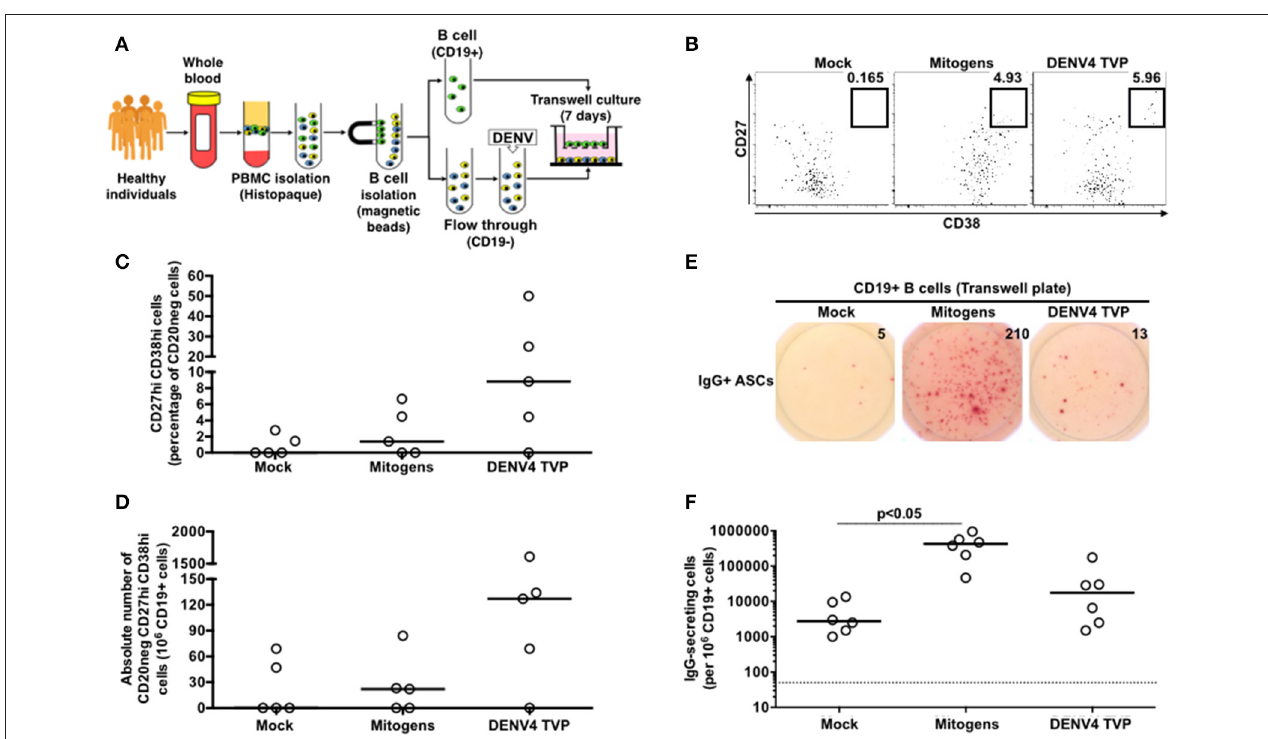
FIGURE 4 | DENV-mediated ASC differentiation is dependent on the physical contact between CD19 + B cells and the remaining PBMCs. (A) CD19 + B cells were isolated from PBMCs ( n = 5) and cultured without physical contact with the flow through (CD19– cells) (in a 1:10 ratio, respectively) in transwell plates. CD19 + B cells were harvested at day 7 of culture and had the ASC phenotype (B–D) and function (E,F) assessed. (F) A total of 2.2 × 10 4 CD19 + cells were added per well, except for the Mitogen culture (2.2 × 10 3 CD19 +